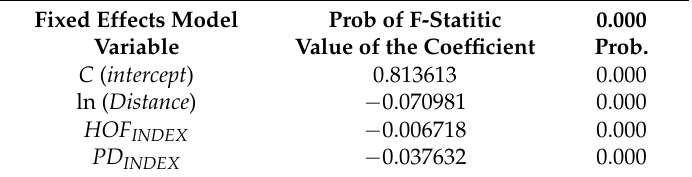
Table 8. Explanatory variables and estimates of coefficients. Source: Authors’